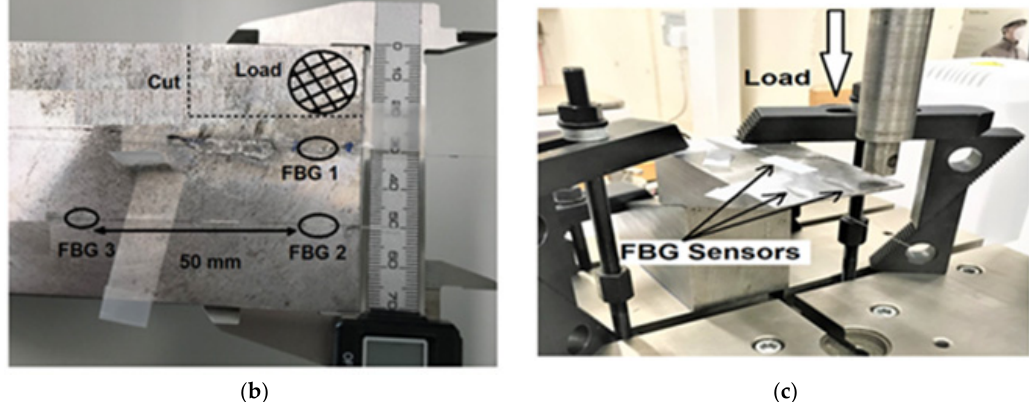
Figure 5. ( a ) Three-dimensional (3D) CAD model highlighting Von Mises stress for identification of sensing elements location; ( b ) FBG sensors location; ( c ) experimental set-up used for loading test.